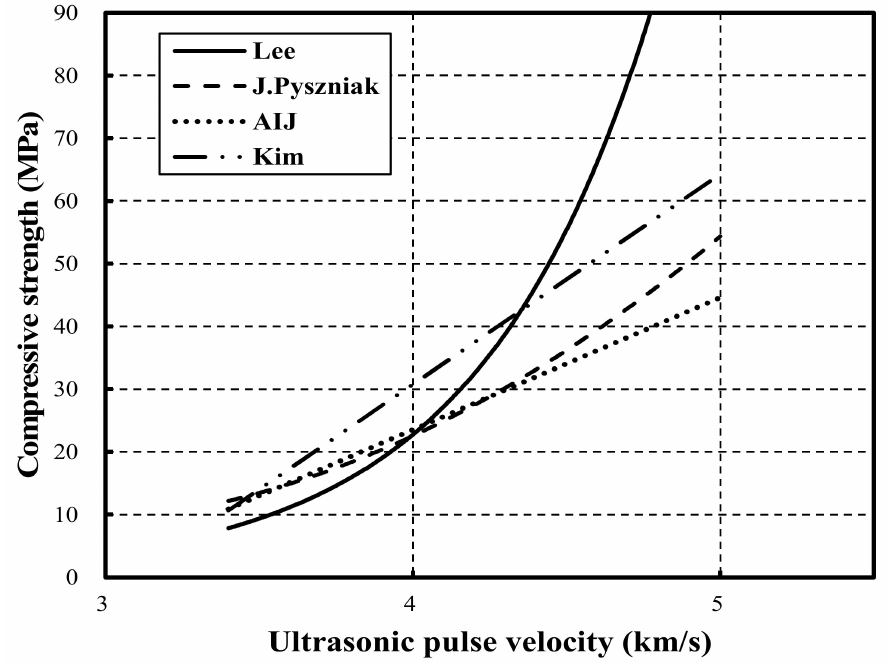
Figure 1. Previous studied relationship between compressive strength and ultrasonic pulse veloc- ity